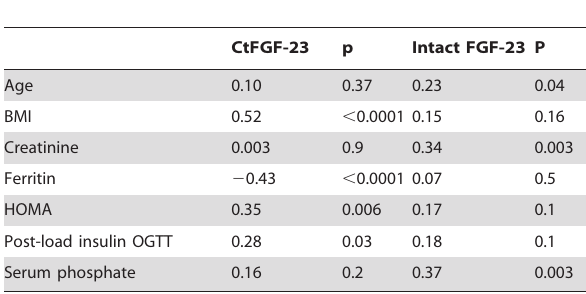
Table 4. Linear correlation analysis of the association between serum intact and CtFGF-23 levels and selected variables in Cohort